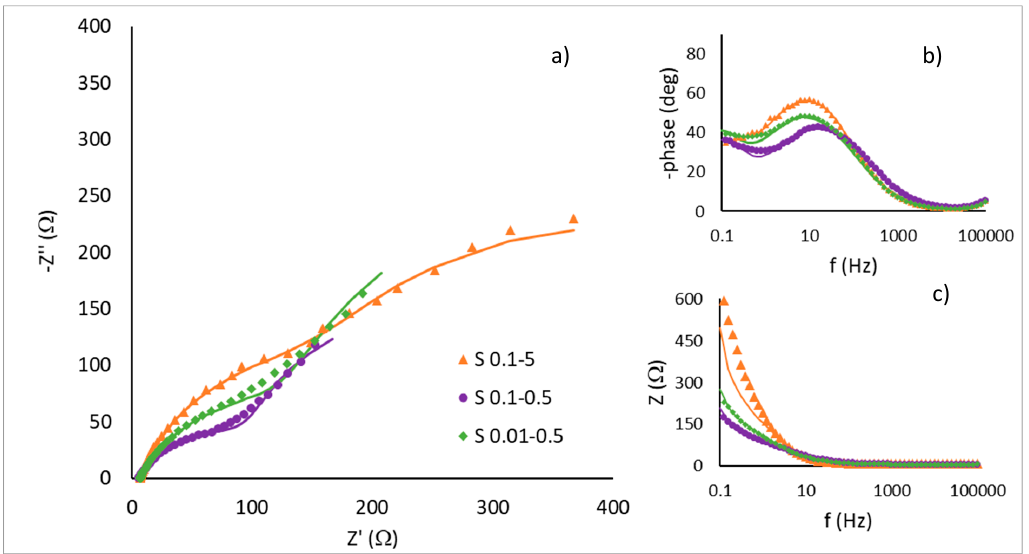
Figure 5. Nyquist diagram ( a ), Bode phase ( b ) and Bode modulus ( c ) recorded in KOH 1 M at open circuit potential.